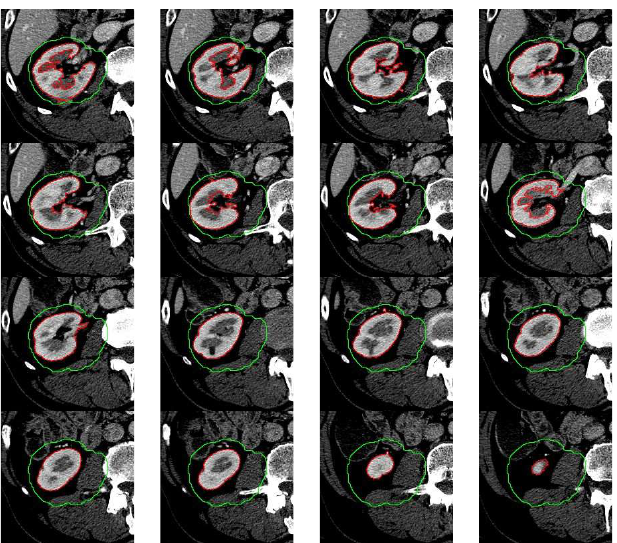
Figure 9. The image shows a visualization of selected slices. Green is the starting search area while red is the automatic kidney system.